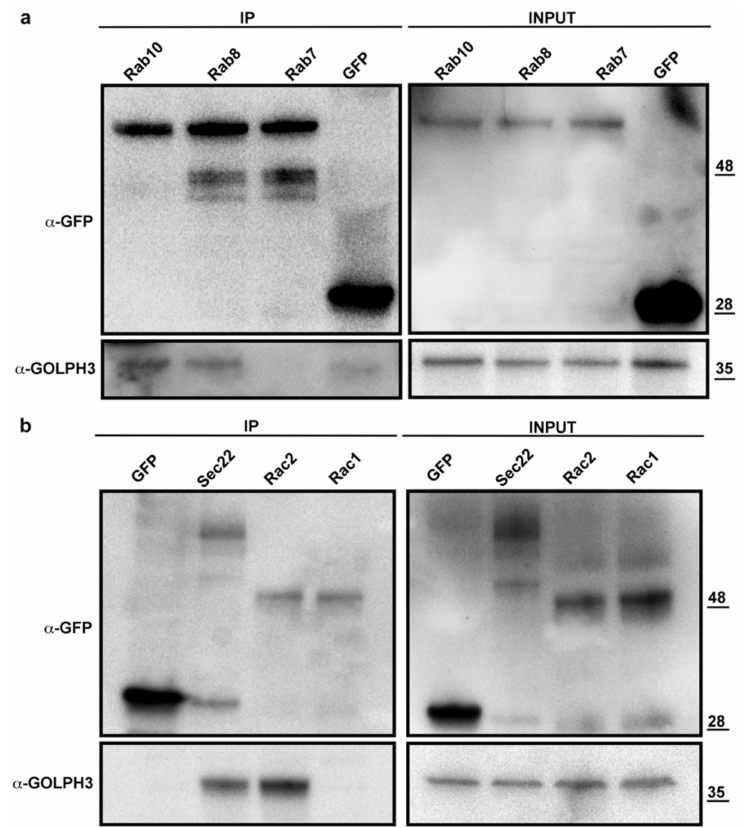
Figure 4. dGOLPH3 interacts with vesicle trafficking and cytoskeleton proteins. ( a ) Protein extracts from testes expressing either GFP or the indicated YFP-tagged Rab protein were immunoprecipitated with GFP traps and blotted to detect either GFP/YFP or GOLPH3. 4% of the total lysates and one third of IP were loaded and probed with the indicated antibodies. ( b ) Protein extracts from Drosophila testes expressing GFP (control) and GFP tagged Rac1, Rac2 and Sec22 were immunoprecipitated with GFP trap and blotted to detects either GFP or GOLPH3. 4% of the total lysates and one third of IP were loaded and probed with the indicated antibodies. Molecular masses in ( a , b ) are expressed in